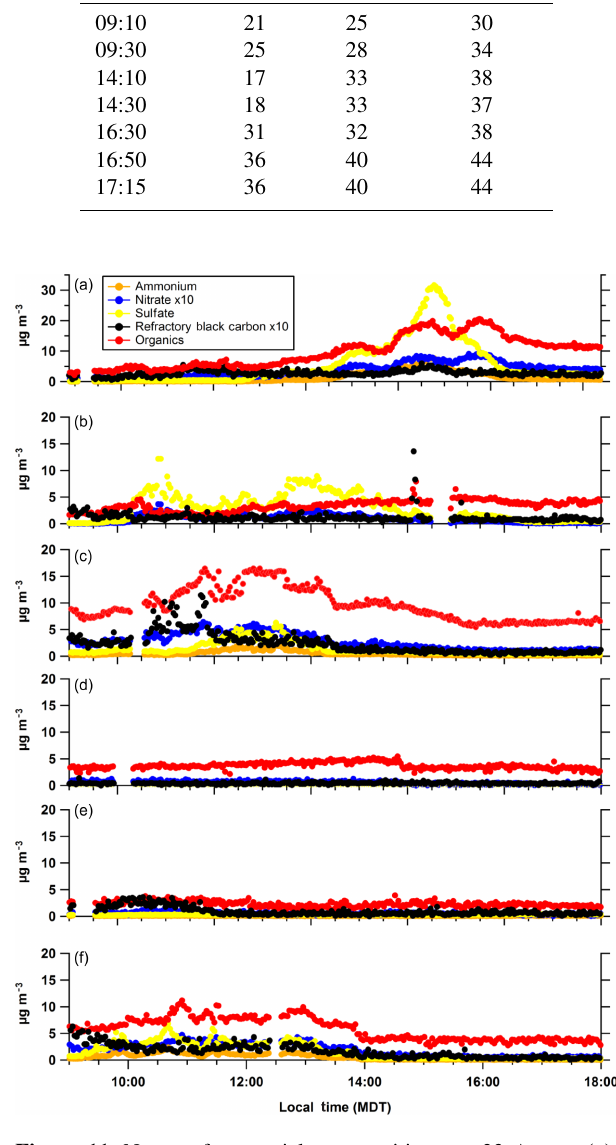
Figure 11. Near-surface particle compositions on 23 August (a) , 3 September (b) , 4 September (c) , 5 September (d) , 6 September (e) , and 7 September (f) . Note the different y axis scale for 23 August and that nitrate and refractory black carbon are shown multiplied by